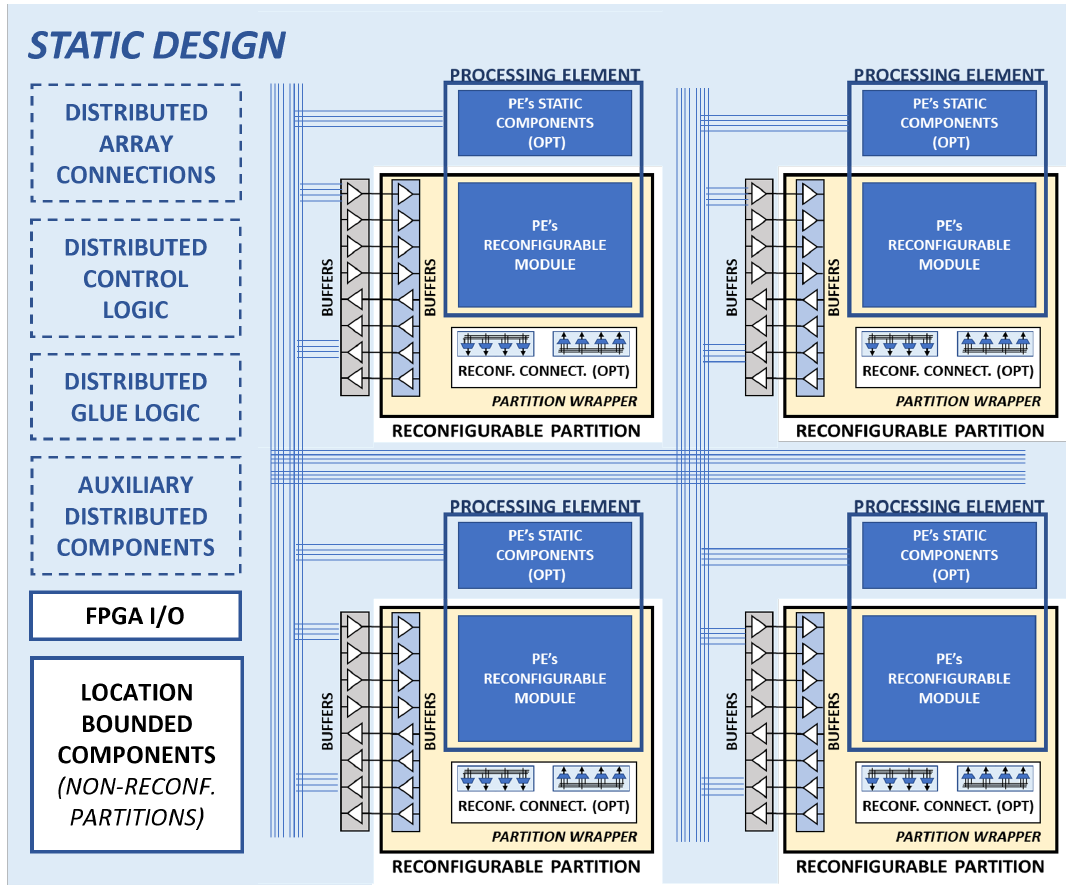
Figure 3. Proposed model of Virtual CGRA using partial reconfiguration mechanism for PE function- ality changes.